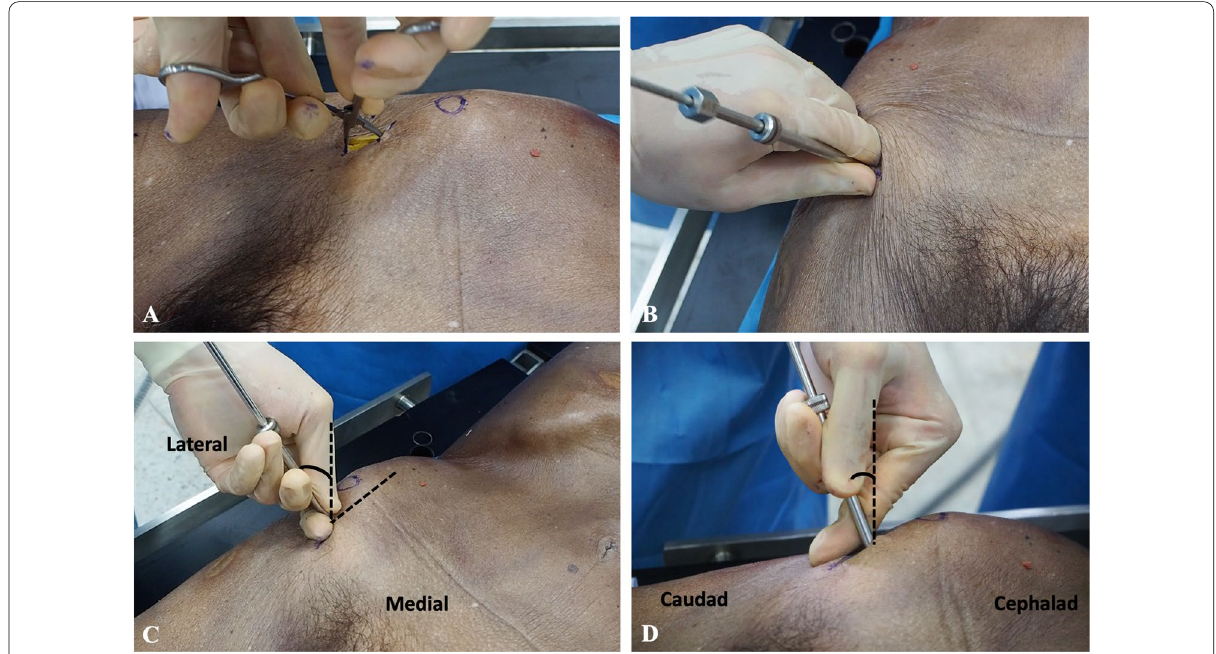
Fig. 2 On the right hemipelvis, a longitudinal split of the fascia over the tensor fasciae latae was achieved with artery forceps ( A ), followed by digital blunt dissection until the anterior inferior iliac spine could be palpated, and then a 2 cm pilot drill hole was made using a three-part drill sleeve ( B